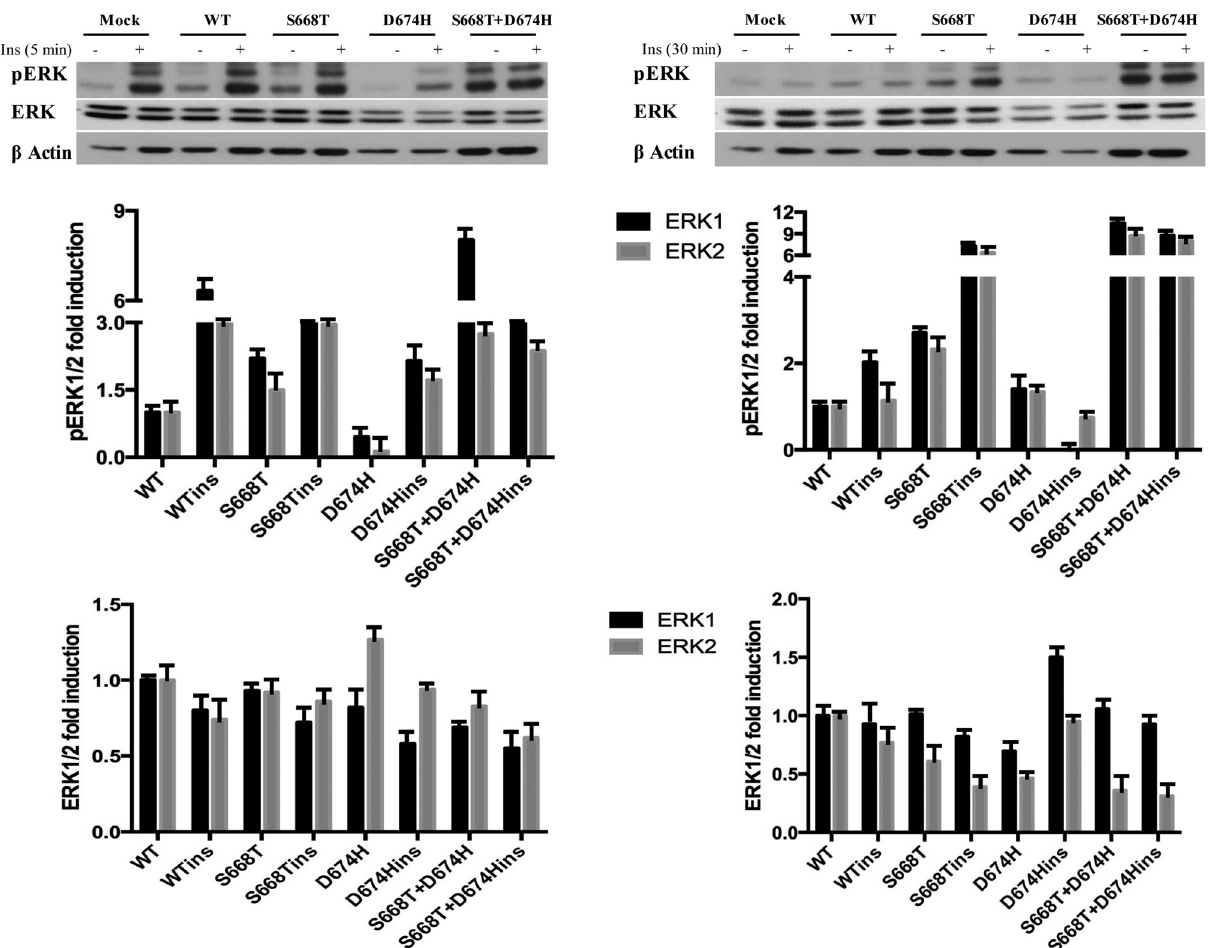
Figure3 -Insulin-inducedphosphorylationandexpressionlevelofERKkinaseisalteredbyS668TandD674Hmutantsin293Tcells.Onehundred (cid:4) gof total protein was fractionated by 10% SDS-PAGE. Blots were labeled with anti-phospho-specific antibodies, stripped and reprobed with non-phospho-specific antibody. Fold induction of phosphorylation was determined by dividing densitometric values of the phospho- band to that of total protein bands. Relative abundance of ERKs was determined by dividing the densitometric values of ERKs to that of